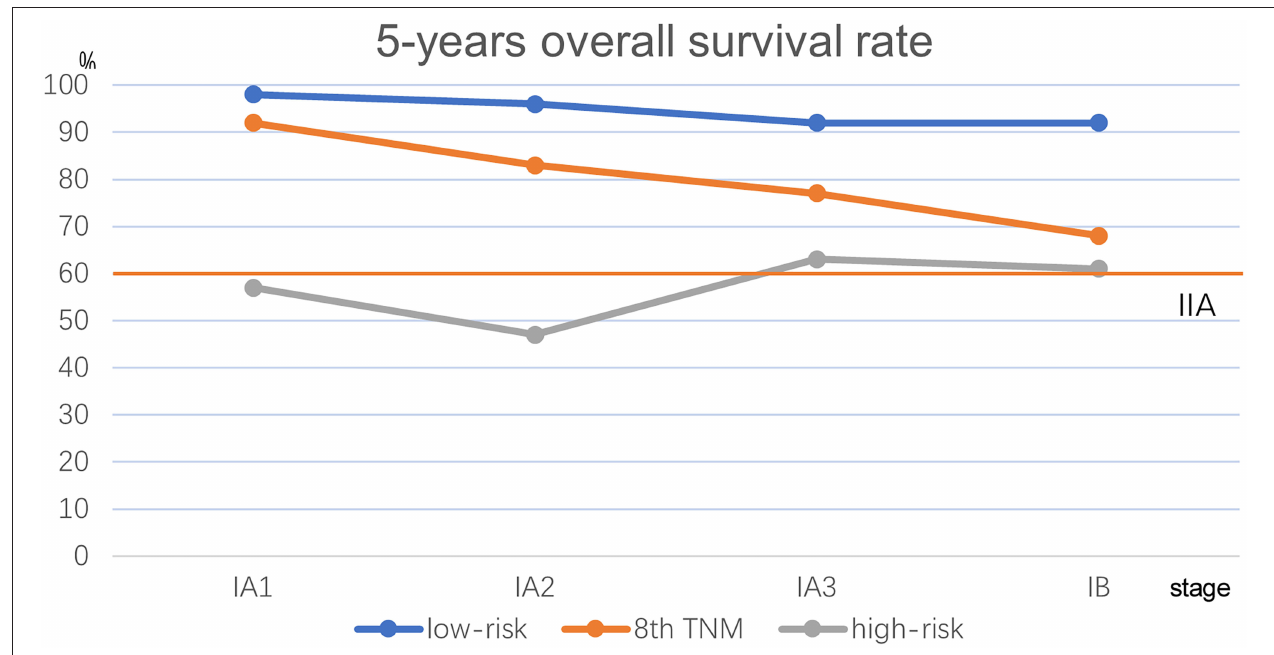
FIGURE 5 | Line chart comparison the 8th TNM classification and TNM-CKP value. Red line depicts the 5-year overall survival rate for stage